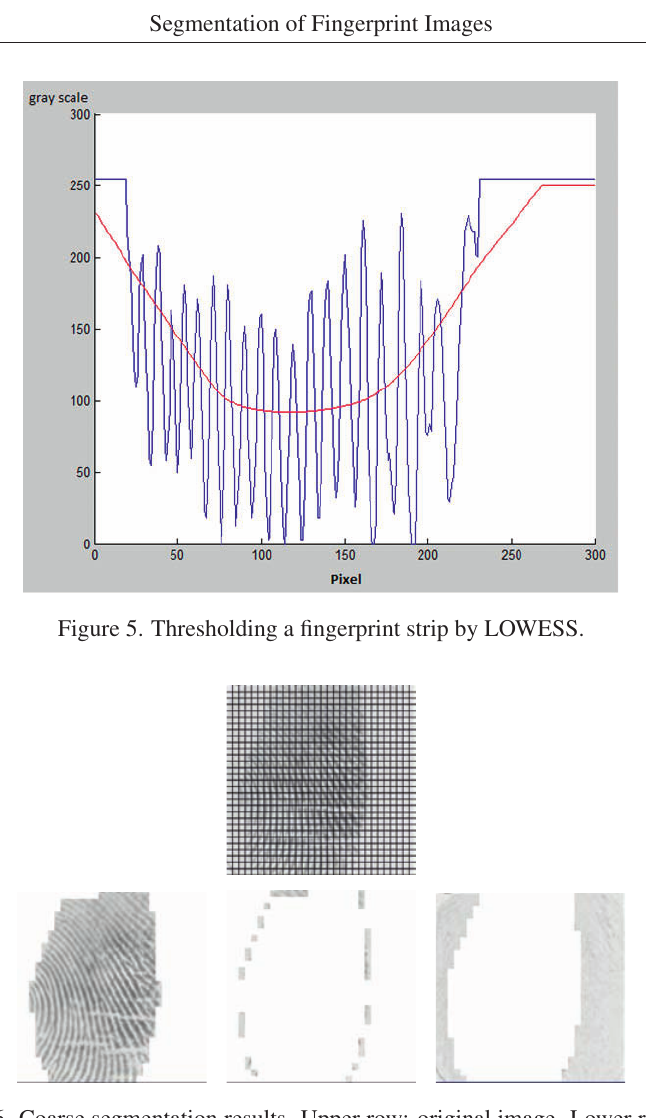
Figure 6. Coarse segmentation results. Upper row: original image. Lower row: the Fo image (left), the Br image (middle), the Ba image (right). The local level. In this level, the fingerprint image is segmented by two different sets of fuzzy rules. One set is for the Fo image and the other is for the Br image. The final segmented image is a combination of the two images. Features employed in this level are the mean and variance of the blocks. Two different fuzzy systems were created as depicted in Table